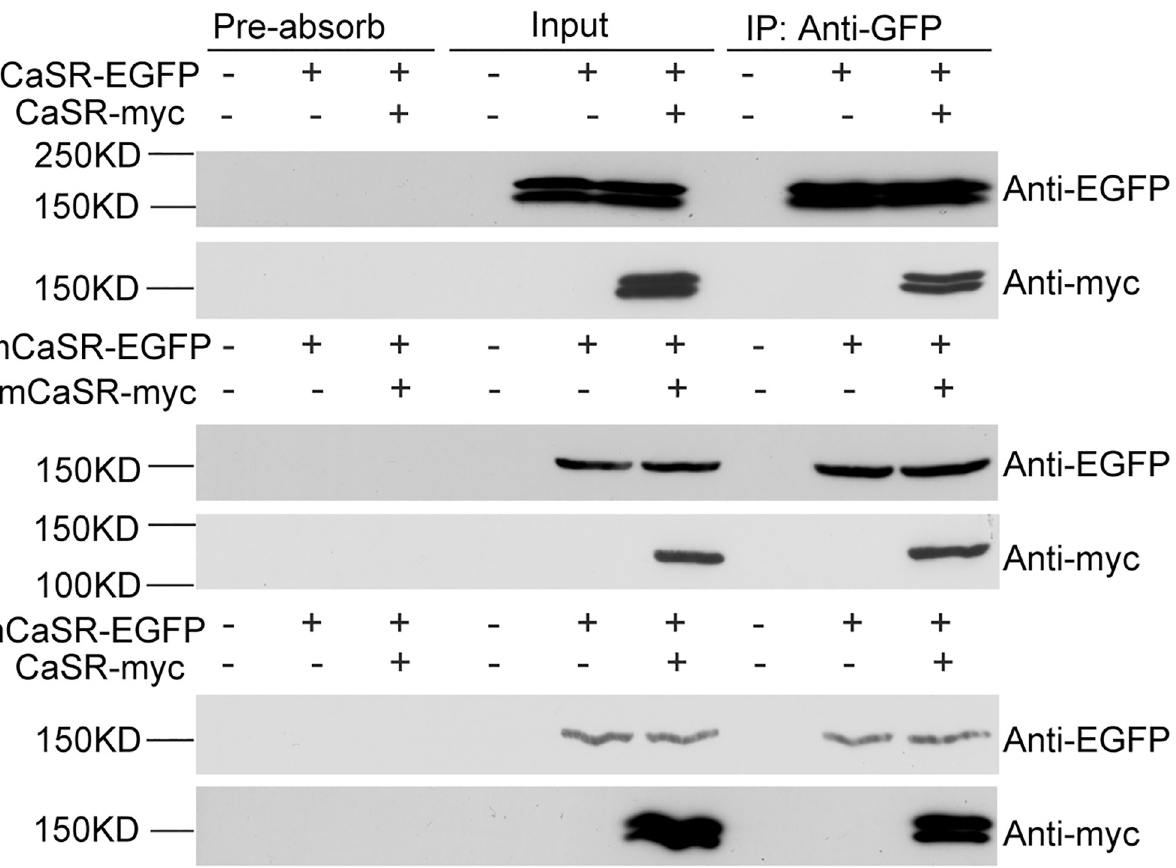
Fig 3. Co-immunoprecipitation of CaSR and mCaSR following co-expression indicate they interact when co-expressed. CaSR-EGFP or mCaSR-EGFP was immunoprecipitated with rabbit anti-GFP antibody. Co-immunoprecipitated proteins were detected with mouse anti-GFP and anti- myc monoclonal antibody. Pre-absorb lanes correspond to the lysates treated identically to immunoprecipitated samples but without anti-GFP antibody. These control lanes indicate that the observed interaction between CaSR, mCaSR, or CaSR and mCaSR is not due to nonspecific binding of either protein to rec-protein A-Sepharose 1 4B